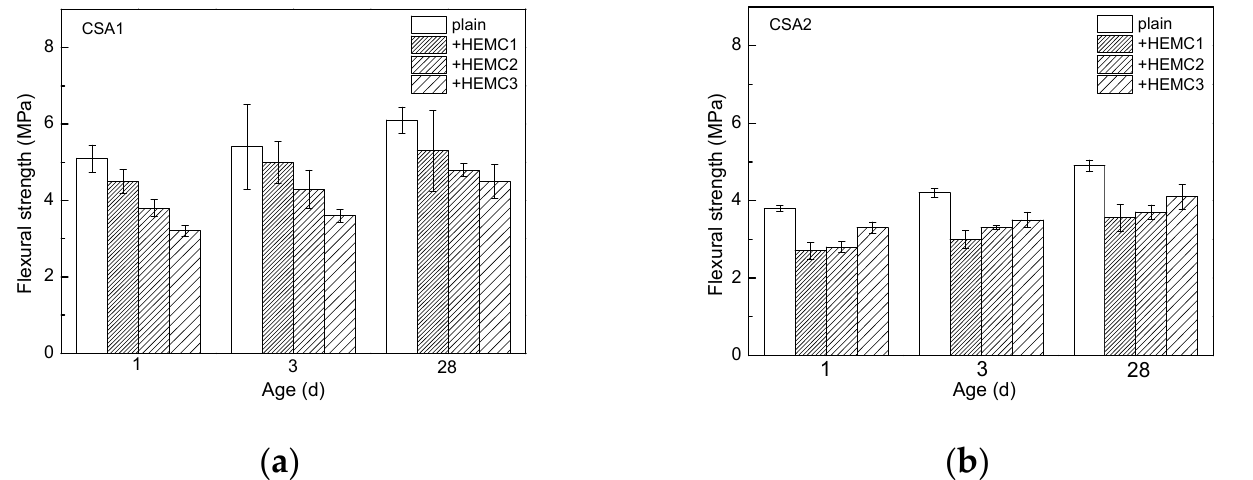
Figure 3. Flexural strength of different CSA cement mortars with and without HEMCs at different curing ages: ( a ) CSA1, ( b ) CSA2.